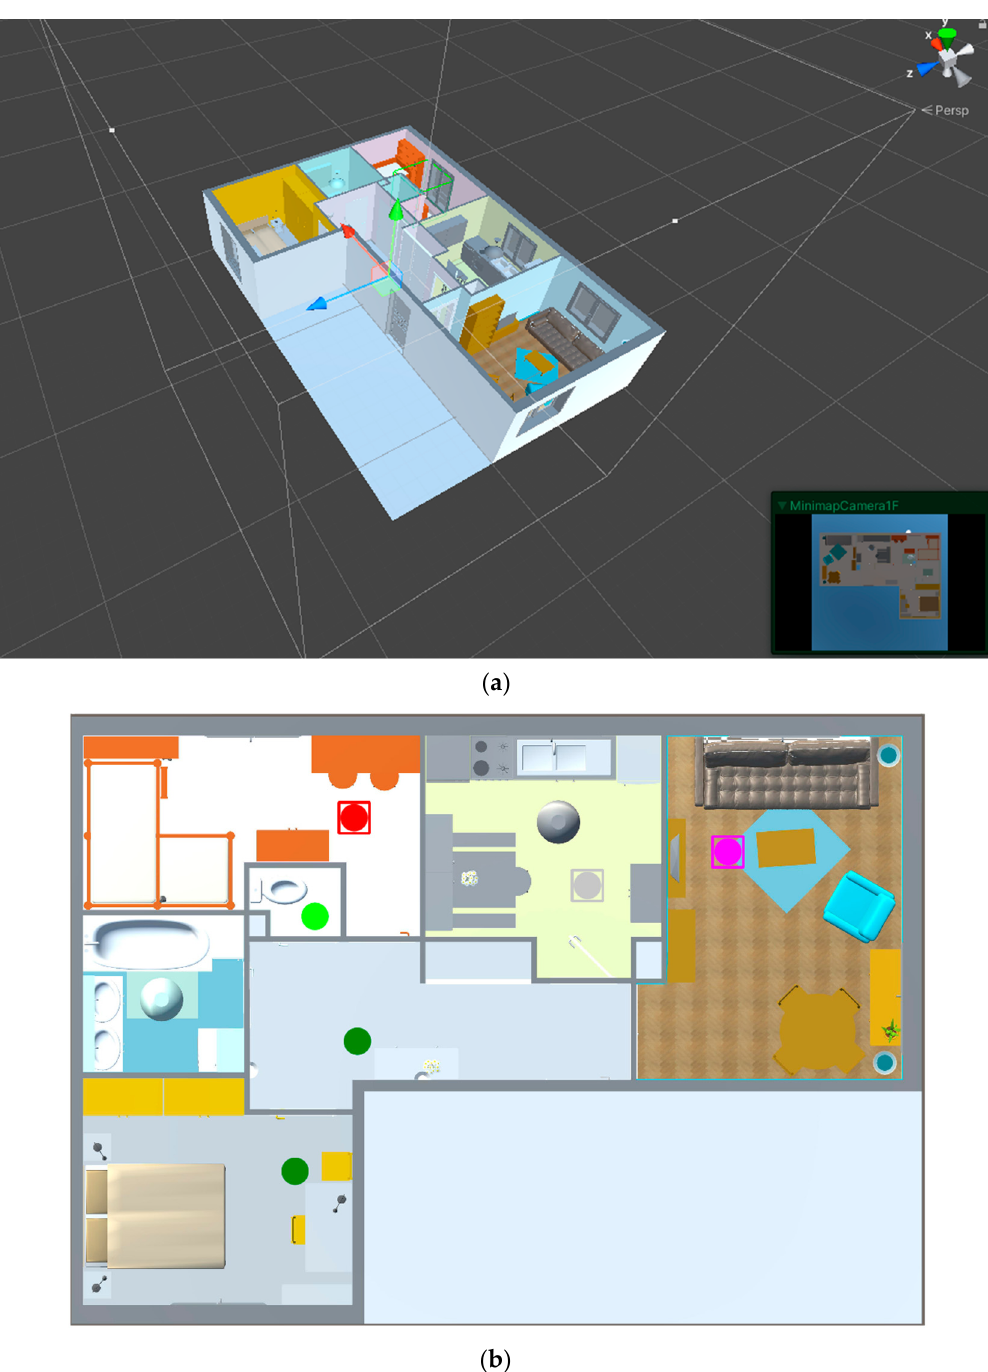
Figure 8. ( a ) Orthographic camera with zenithal perspective generated for each floor to generate the real-time mini-map. ( b ) Example of mini-map where six markers have been left during the VR exploration of the apartment shown in Figure 2d.